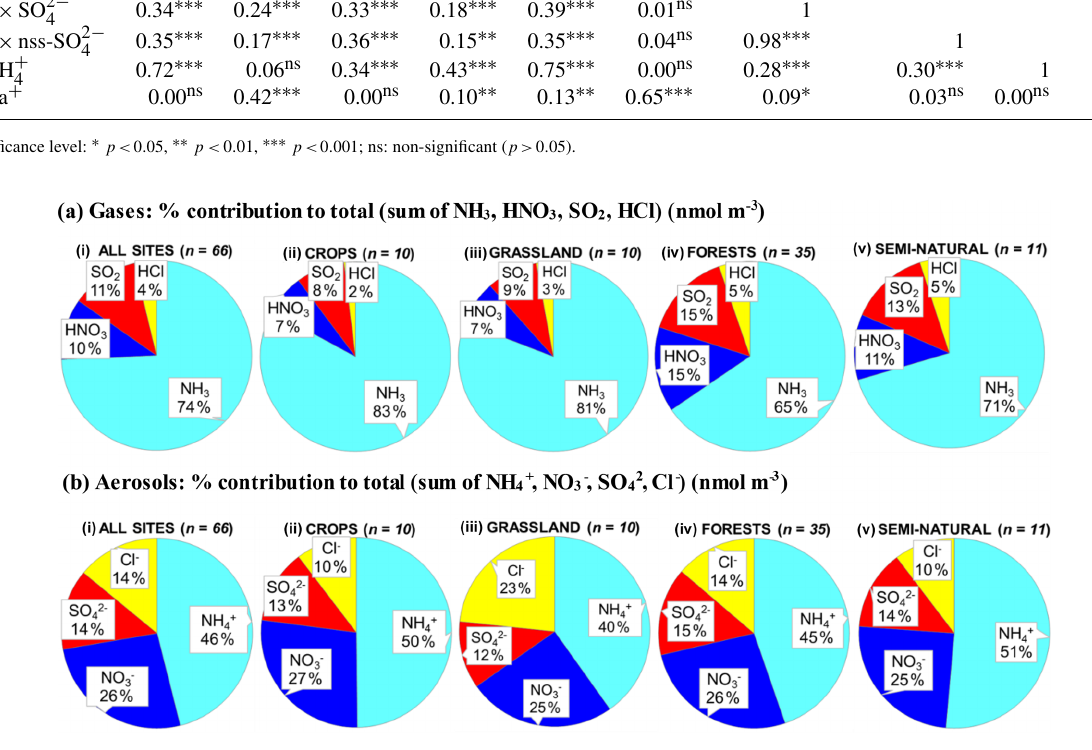
, NO − , SO 2 − , Cl − ). Data 4 3 4